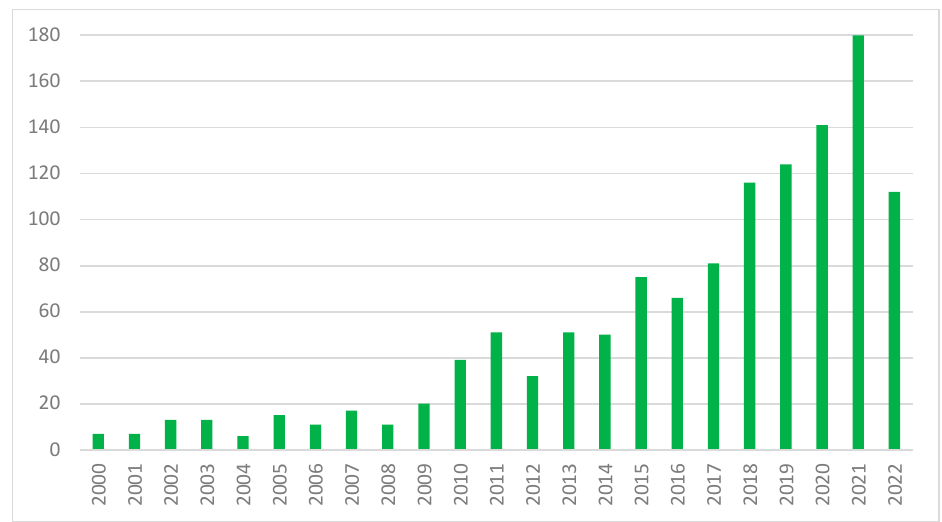
Figure 1. The number of publications related to sustainable transport in the period 2000–2022. Source: own elaboration based on the created database. Table 1. Top ten research areas in sustainability